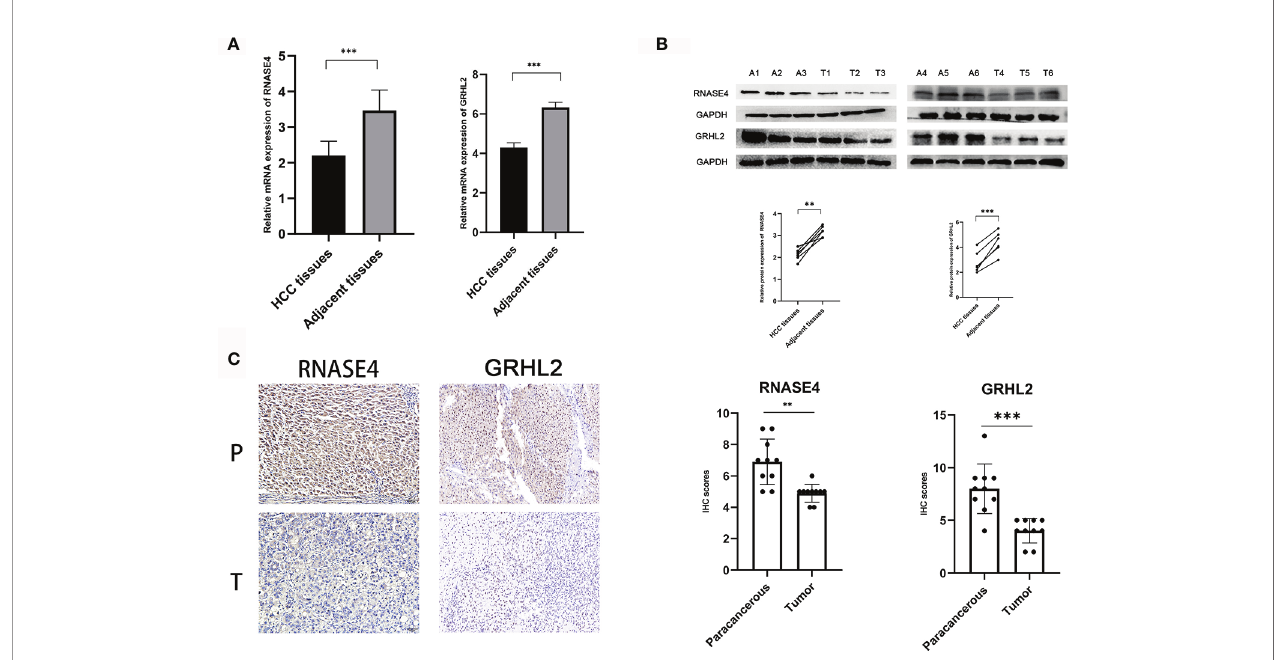
FIGURE 4 | Veri fi cation of the expression of diagnosis-related genes. (A) RT-qPCR assay for RNASE4 and GRHL2 in HCC (n = 30). (B) Western blot assay for RNASE4 and GRHL2 in HCC (n = 6). (C) Immunohistochemistry assay for RNASE4 and GRHL2 in HCC (n = 10). **<0.01